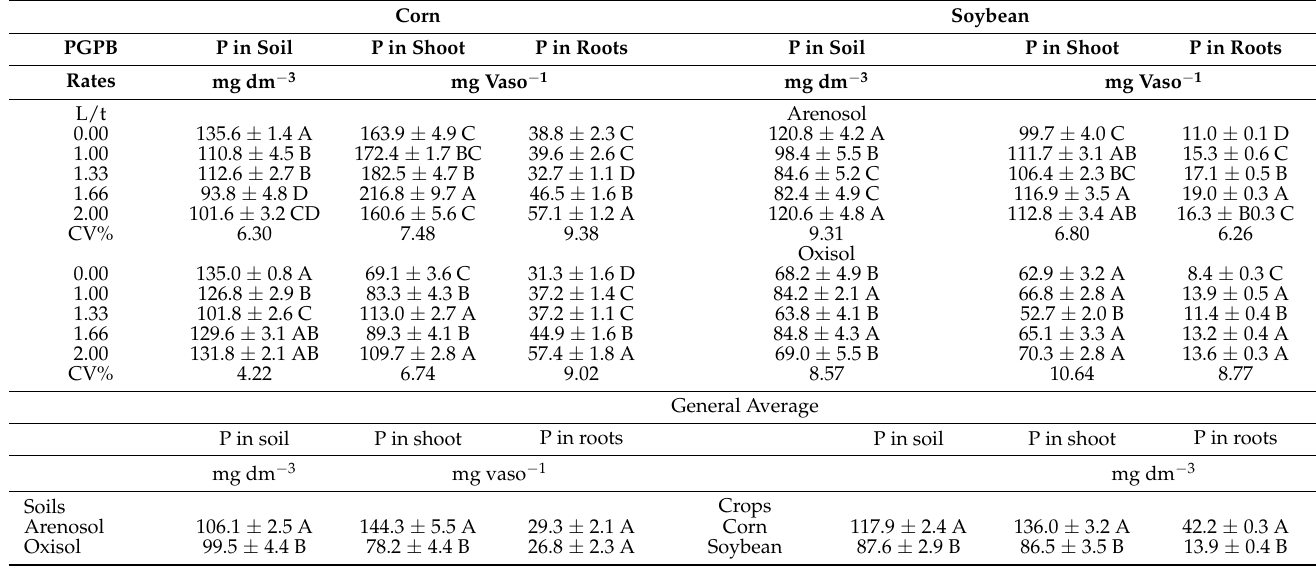
Table 3. Phosphorus (P) in soil (arenosol and oxisol) and plants (shoot and root parts) with the application of monoammonium phosphate sprayed with rates of plant growth-promoting bacteria (PGPB; 0; 1; 1.33; 1.66; and 2.0 L/ton of fertilizer), cultivated with corn and